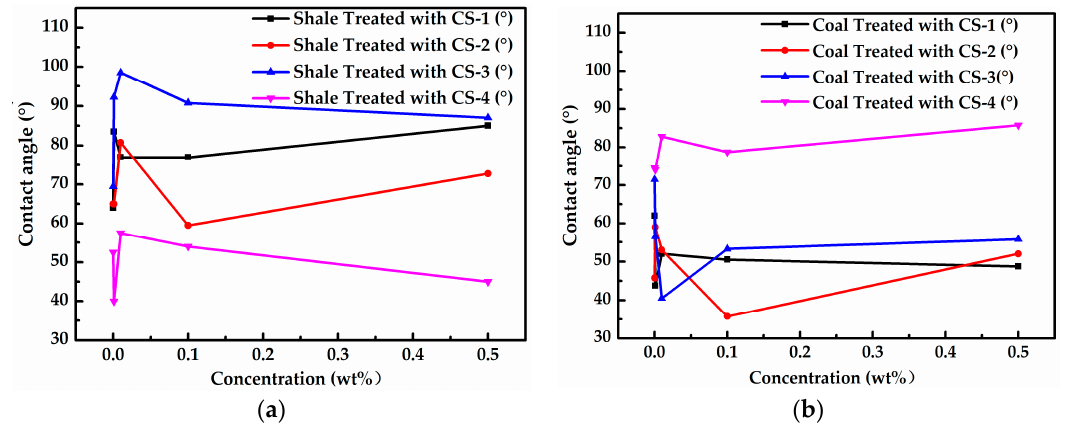
Figure 4. Effect of anionic surfactants to the contact angles of the Longmaxi shale and the Longtan coal samples.